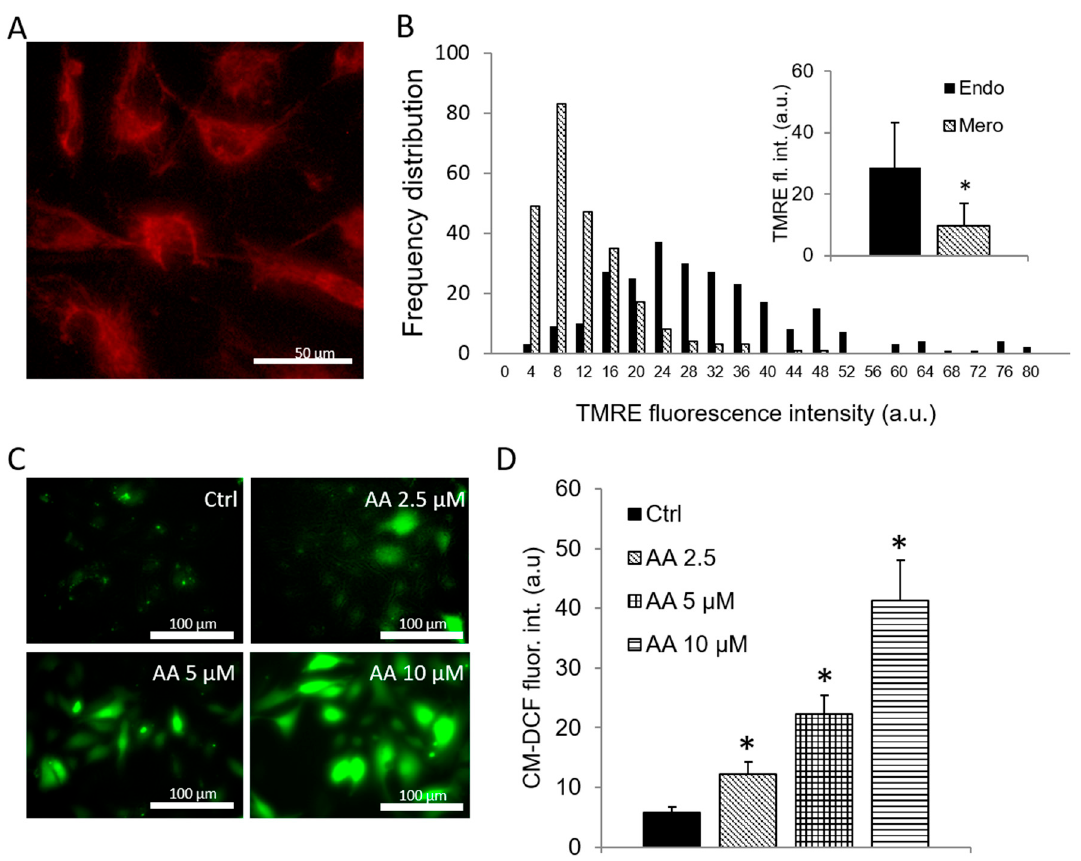
Figure 4. Mitochondrial membrane potential and reactive oxygen species (ROS) generation in human mesothelioma cell line. ( A ) Mitochondria of representative Mero-14 cells are stained with ∆Ψ m-driven fluorophore TMRE showing presence of functional mitochondria. ( B ) Frequency distribution and average ∆Ψ m of individual Mero-14 and endothelial (Endo) cells. ( C ) Representative images of Mero-14 cells stained with ROS-sensitive dye CM-DCF in response to increasing antimycin A (AA) concentrations. ( D ) Summary of ROS data ( n = 7–13 / group). Data are means ± SEM; * p < 0.05 vs Mero or Ctrl.